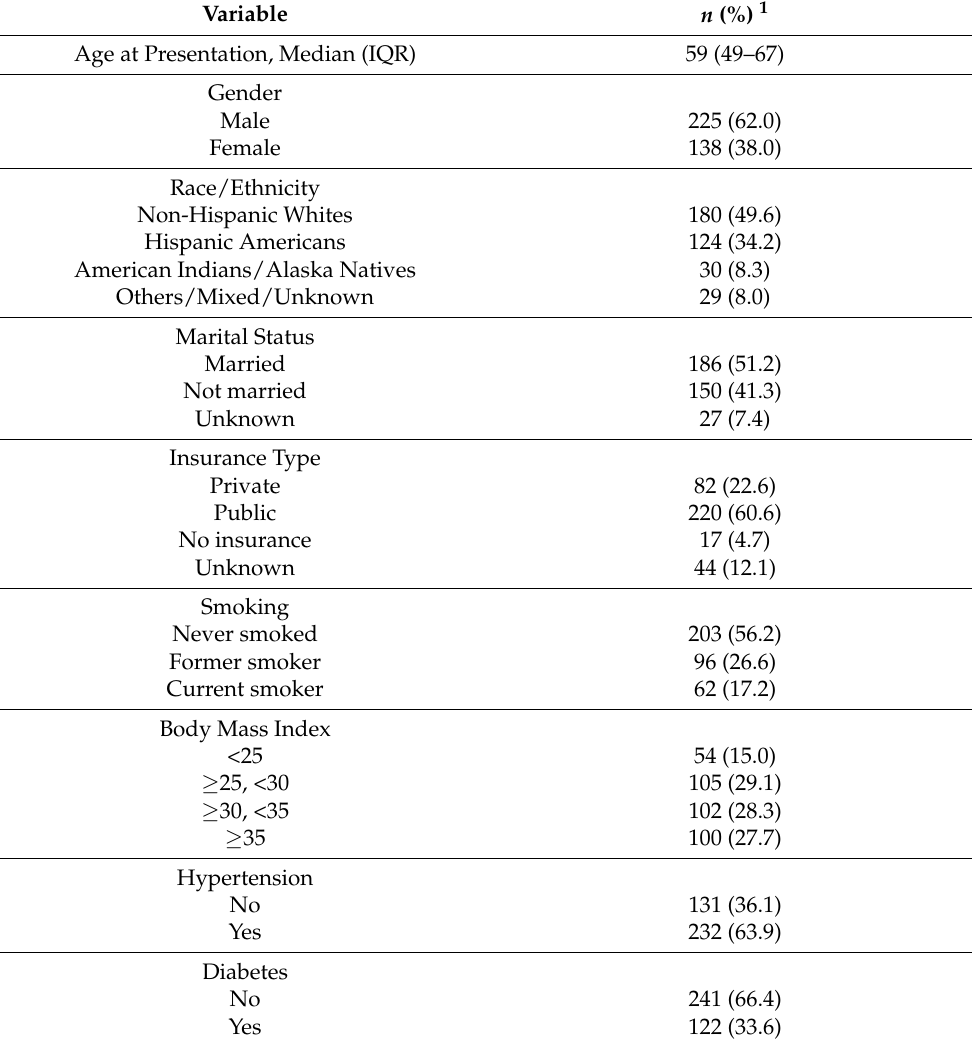
Table 1. Characteristics of patients included in the